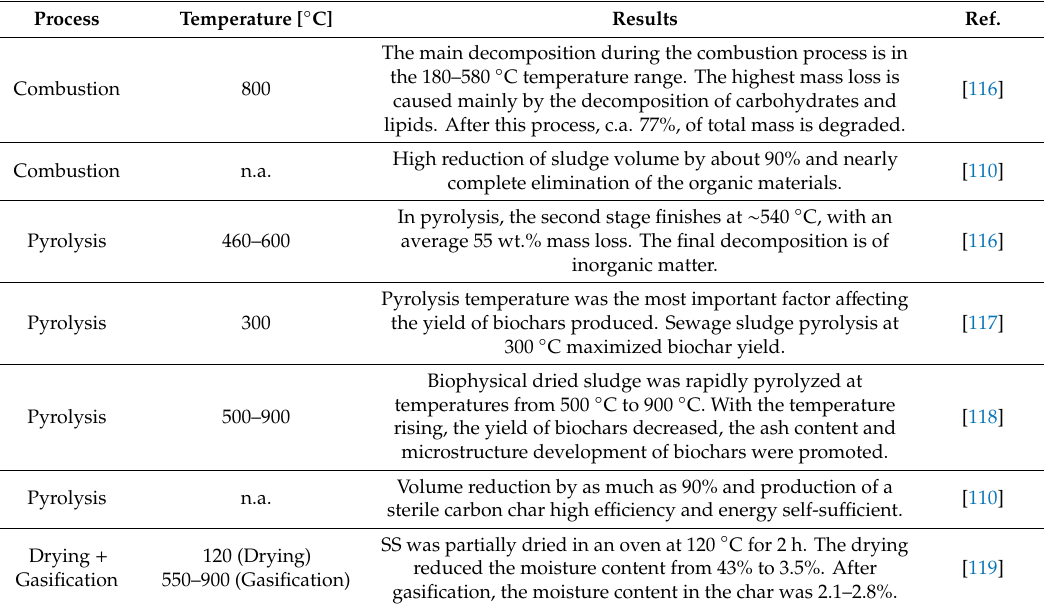
Table 3. Several applications of thermal